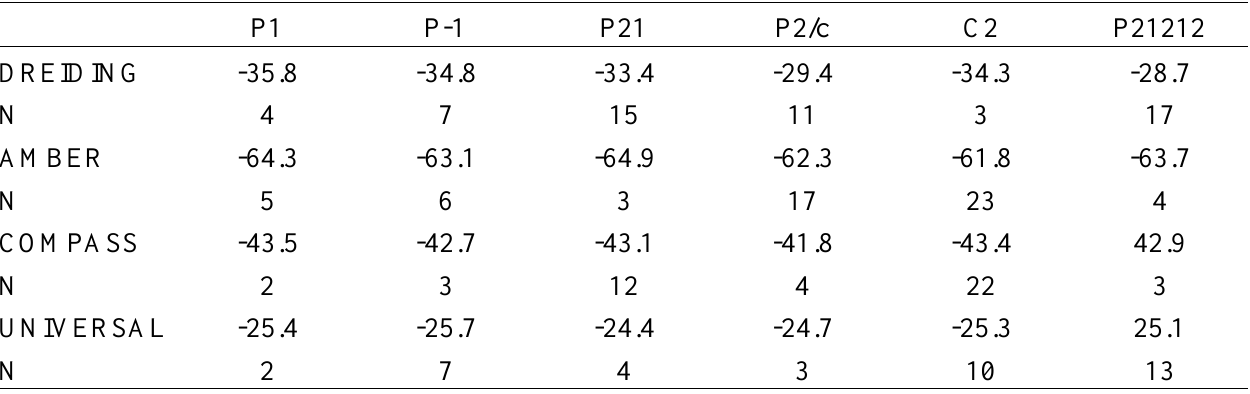
Table III. Lattice Energy and Number of Low-Energy structures of vitamin C ( L-Ascorbic Acid)